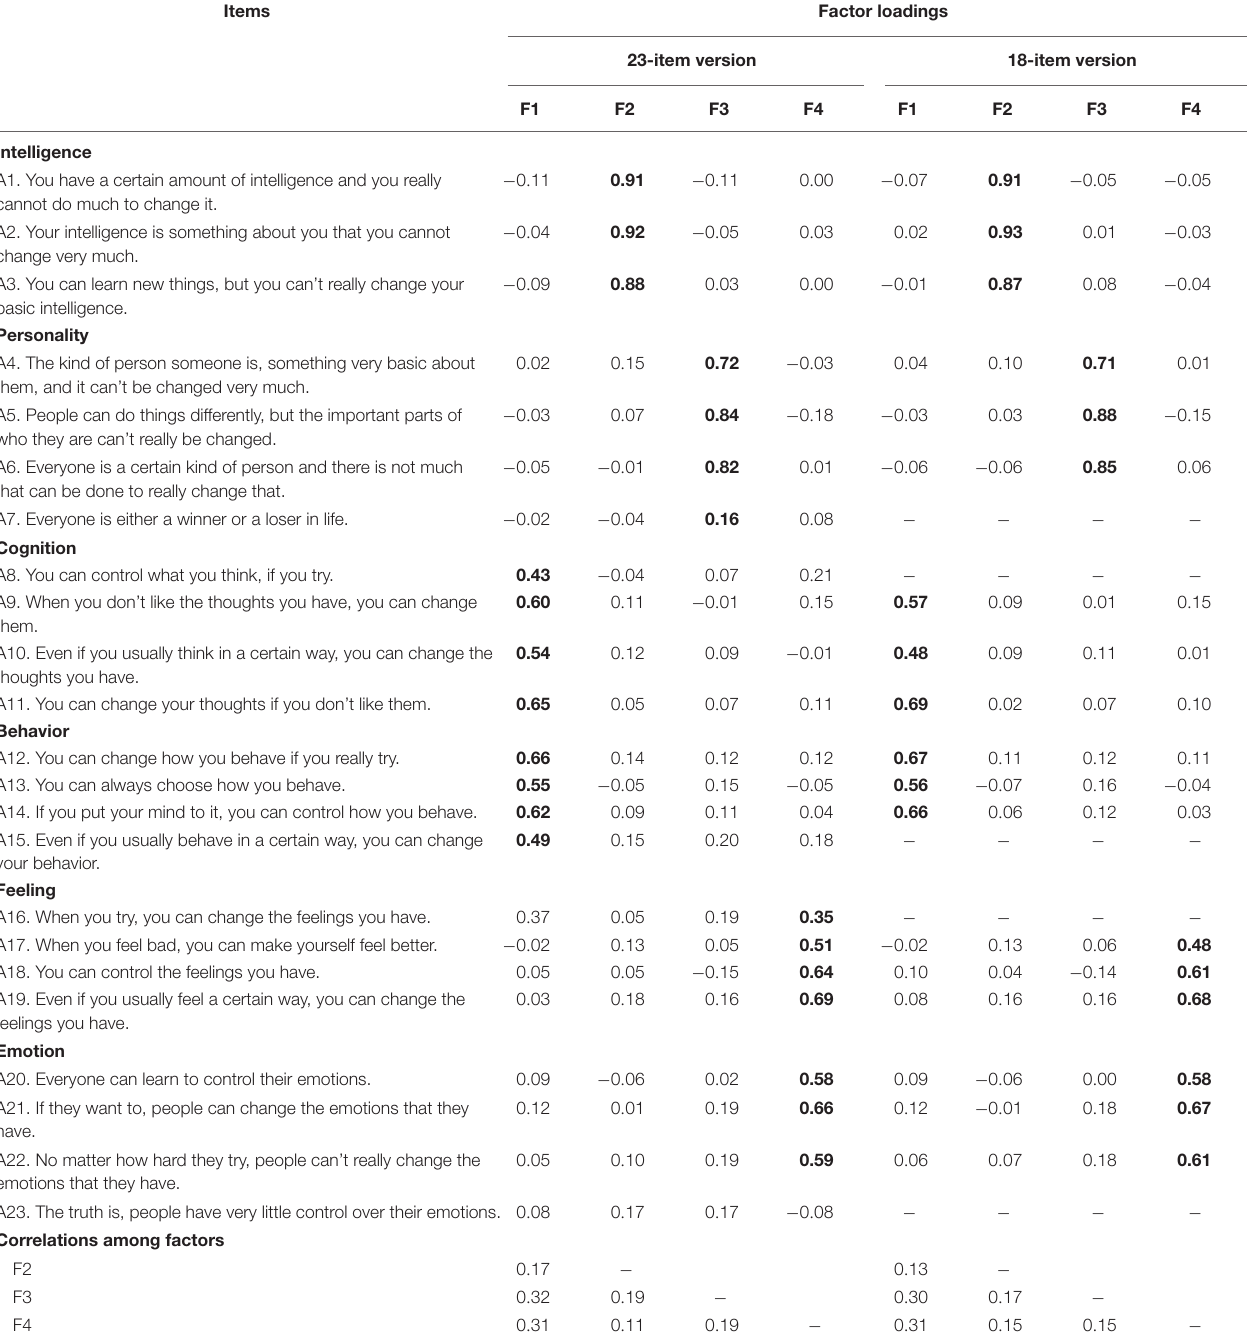
TABLE 4 | Results of exploratory factor analysis (EFA) of the Implicit Theories Scale from Study 2. Items Factor